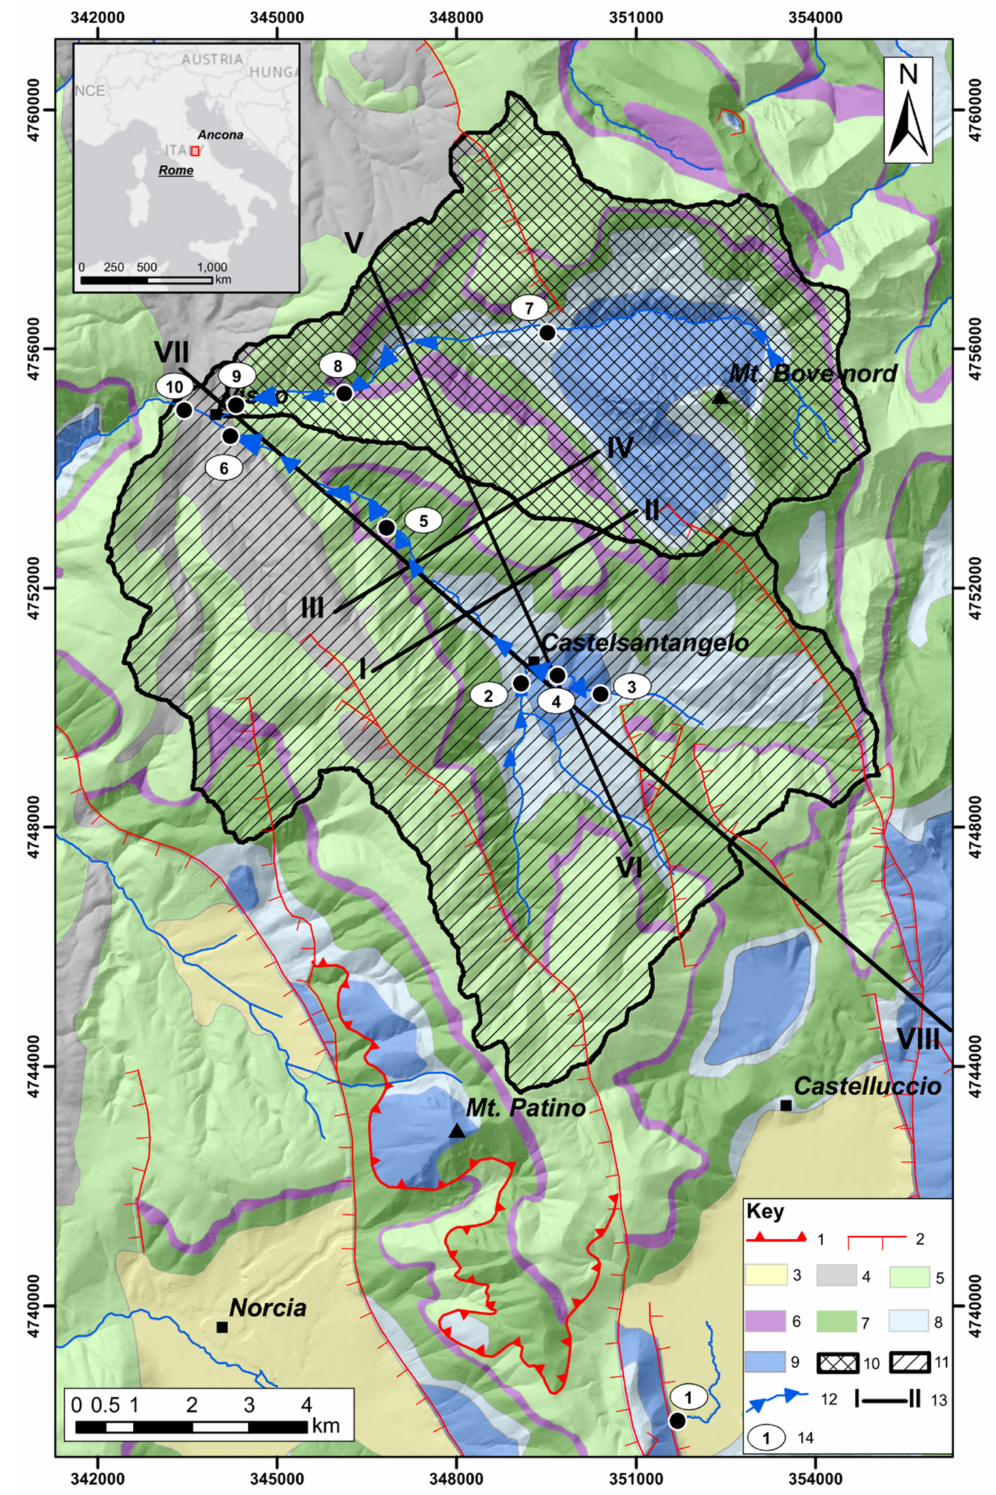
Figure 2. Hydrogeological complexes map and main tectonic lineaments of the study area mod- ified from [46]. (1) Thrust fault (2) Normal fault (3) Quaternary deposits (4) Miocenic aquiclude (SVC) (5) Scaglia calcarea aquifer (SCA) (6) Marne a Fucoidi aquiclude (MF) (7) Maiolica aquifer (MAI) (8) Jurassic aquiclude (JUR) (9) Calcare Massiccio—Corniola Formations, Basal aquifer (BAS) (10) Ussita basin (11) Castelsantangelo basin (12) Linear spring (13) Trace of geological cross-sections. (14) Monitoring